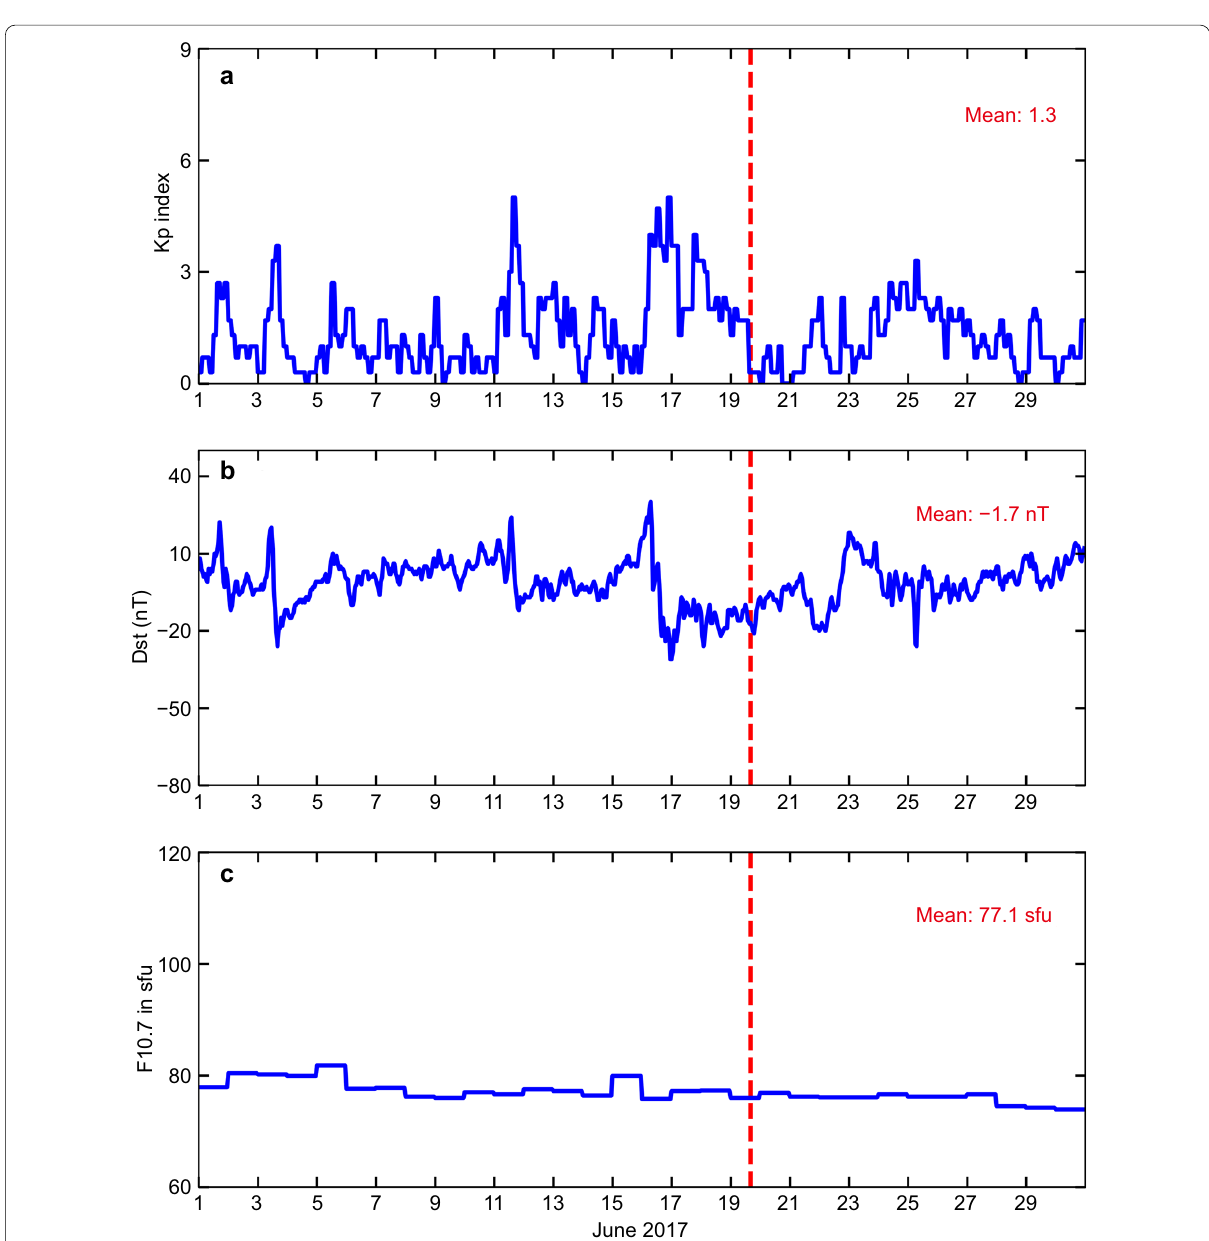
Fig. 6 The geomagnetic indices, i.e. Kp ( a ), Dst ( b ), and solar index F10.7 ( c ) in June 2017. The red vertical dashed line denotes the experiment time at 16:00 HKT on 19 June